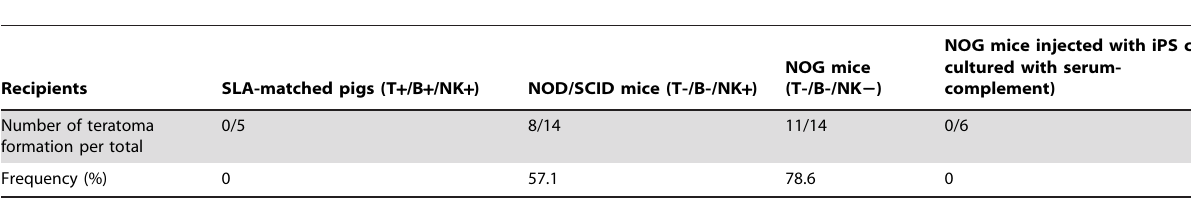
Table 1. The teratoma formation in SLA-matched pigs and immunodeficient mice following injection of C1 iPS cells.